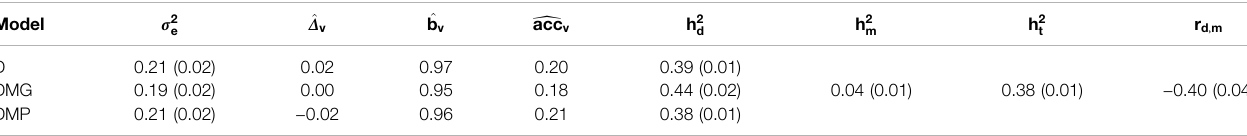
TABLE 4 | Fitness of the model and genetic parameters for all models tested.